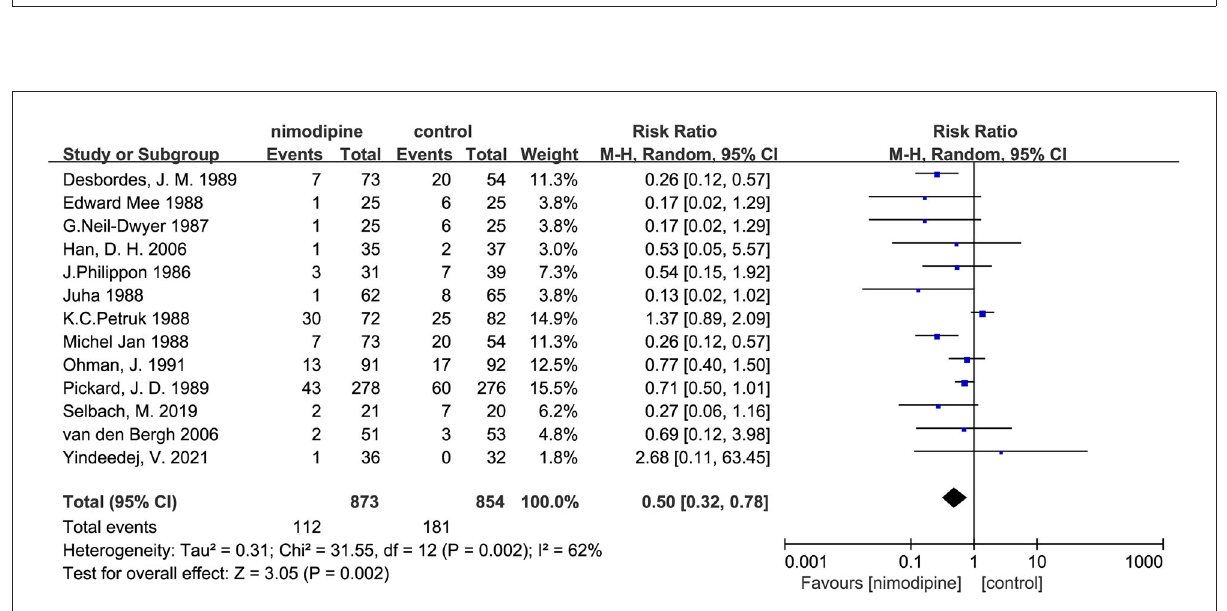
FIGURE7 Efficacy of nimodipine-use in the prevention of mortality in SAH